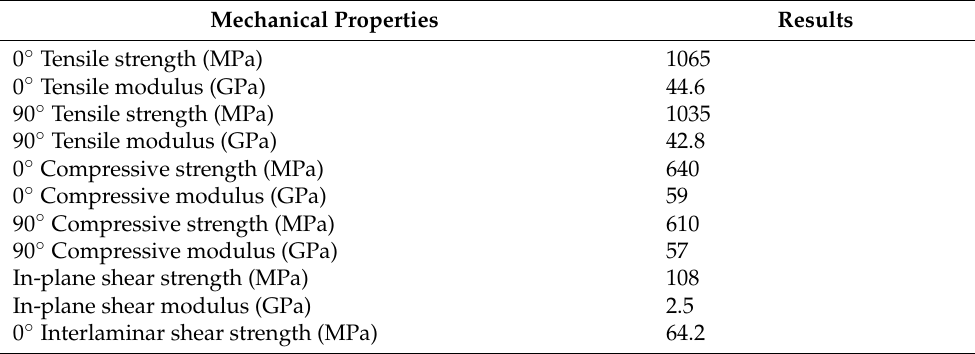
Table 1. Mechanical properties of MTM49-3-42%-3KFT300B40B-5H-283-1000.